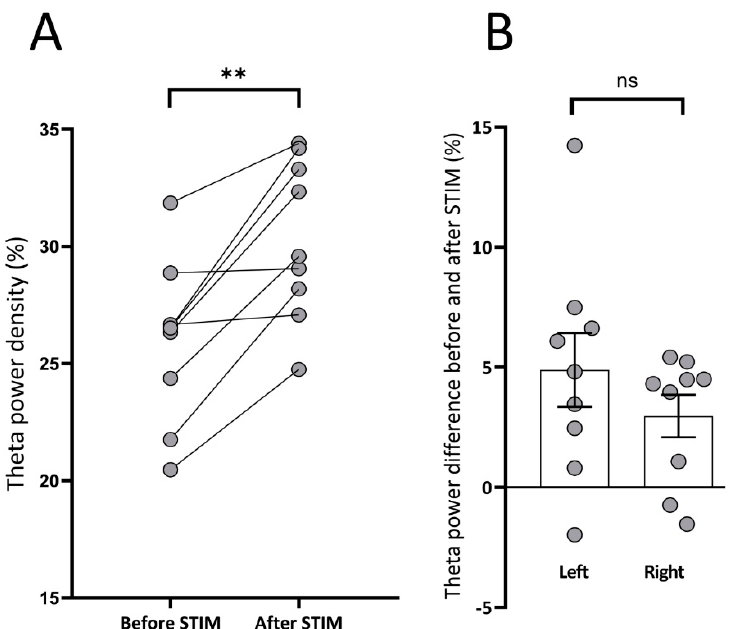
Figure 5. The effect of deep brain stimulation on theta power density. ( A ) The average theta power density of individual animals before and after the stimulation trains. Dots represent the average theta power of an animal. All animals had an increase in theta power following the stimulation train (** p < 0.01). ( B ) Theta power density changes in the two hippocampi. Positive values indicate an increase, negative values a decrease in the absolute theta power after stimulation trains in the left and right hippocampus (dots: individual animals, box and whisker: mean ± SEM, ns = non-significant). Two animals had a decrease in theta power on the right side and one animal on the left, but these three were different animals, and the average of left and the right side was also increased in these cases.